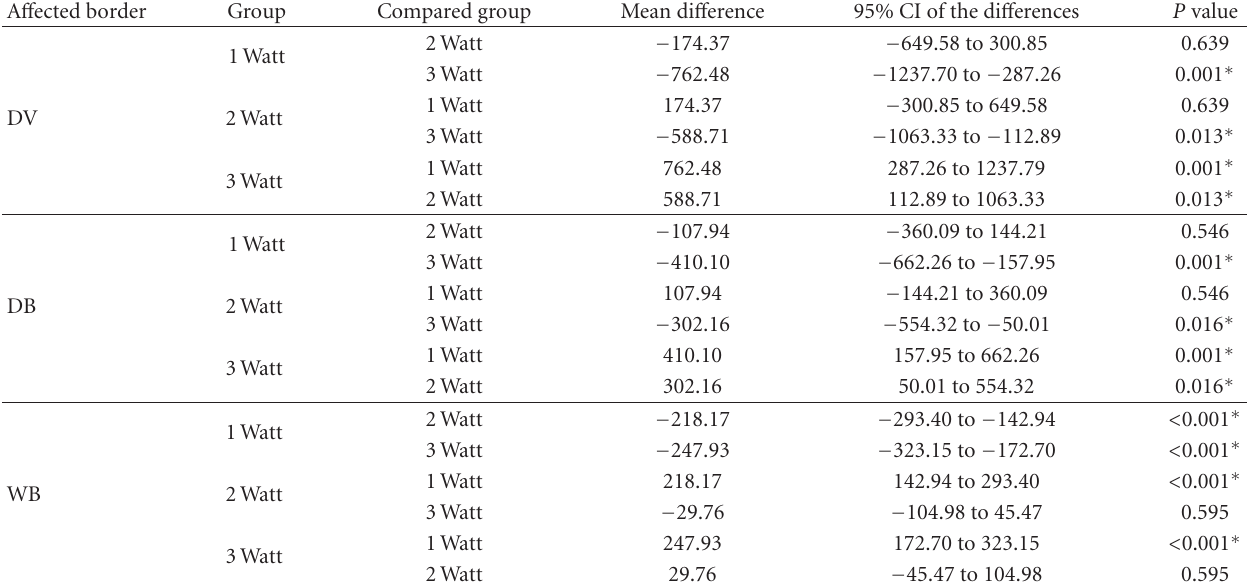
Table 3: The comparisons of the di ff erences of histologically a ff ected borders by the groups. A ff ected